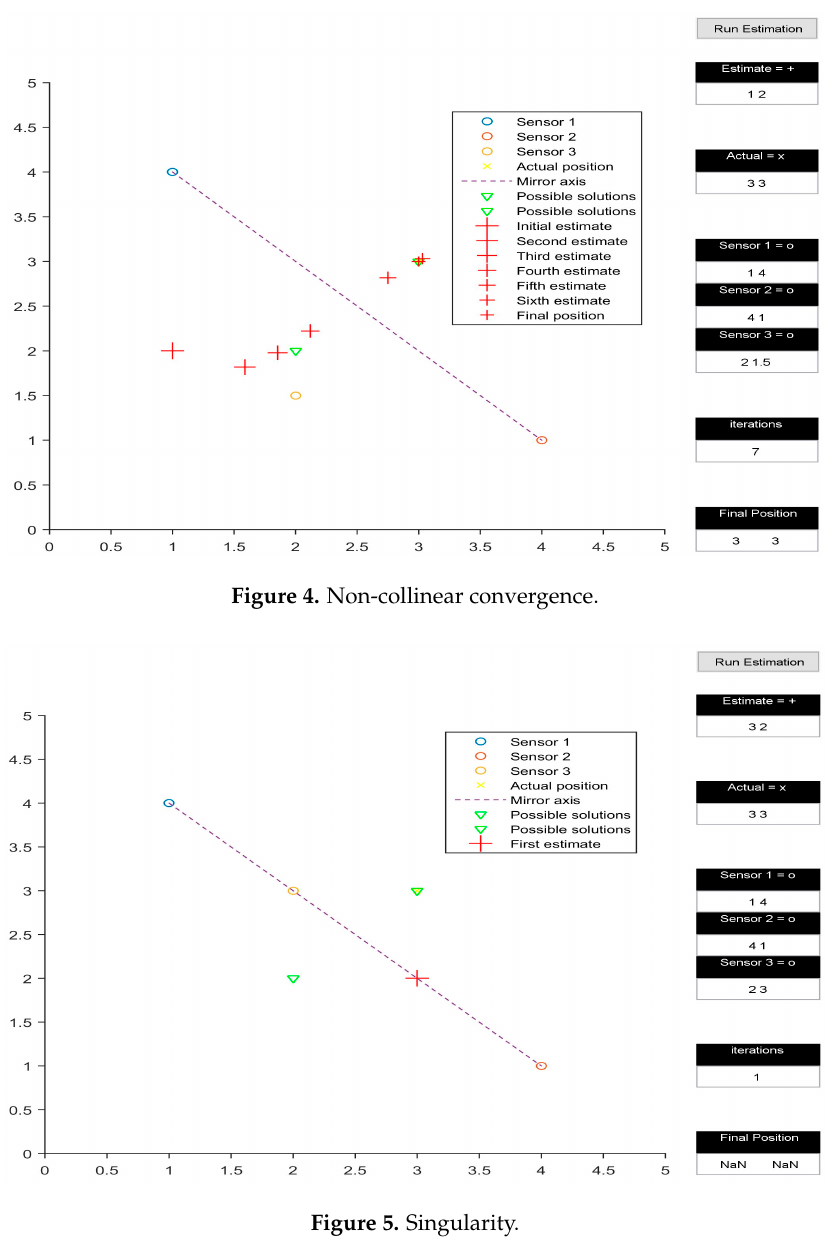
Figure 5. Singularity. Figure 5.